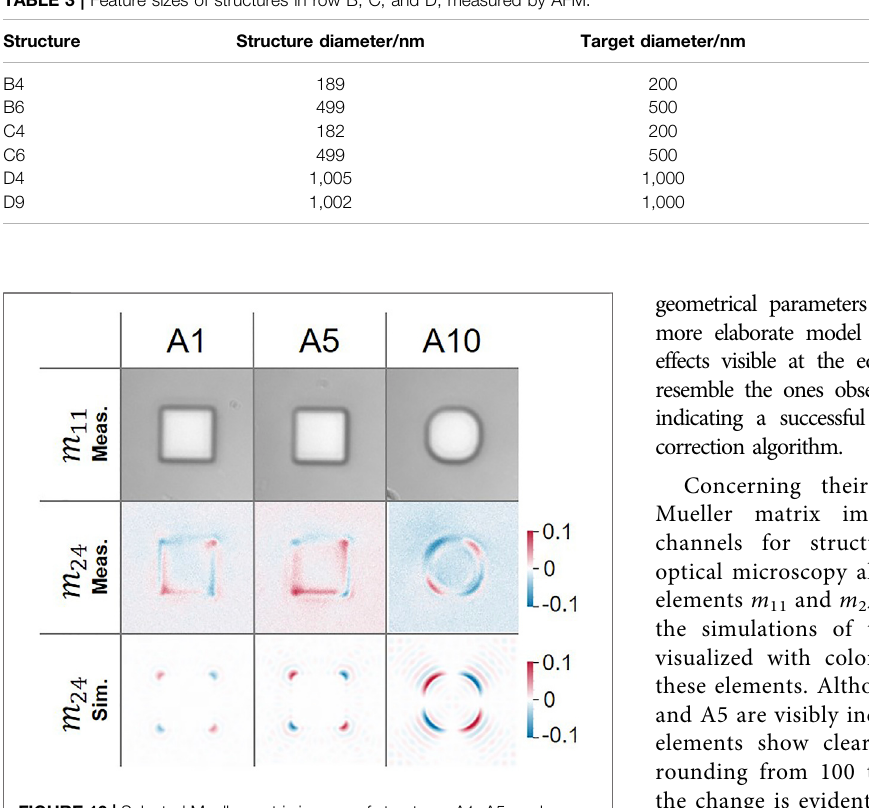
FIGURE 10 | Selected Mueller matrix images of structures A1, A5, and A10: Measured m 11 element and measured and simulated m 24 elements. Measurement results from drift corrected measurements.